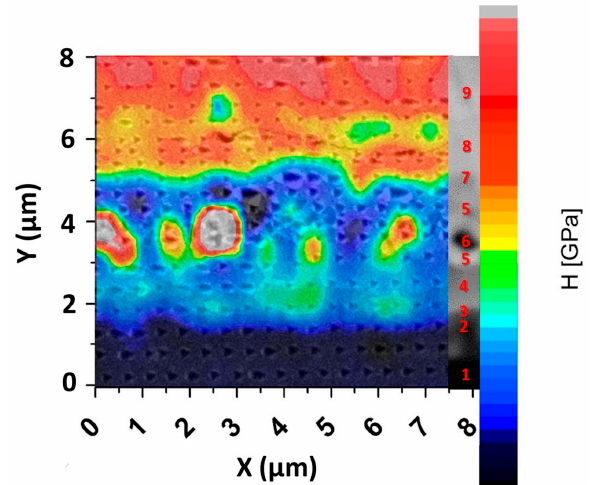
Figure 5. Nanoindentation analysis at the TiAl-Ni interface.